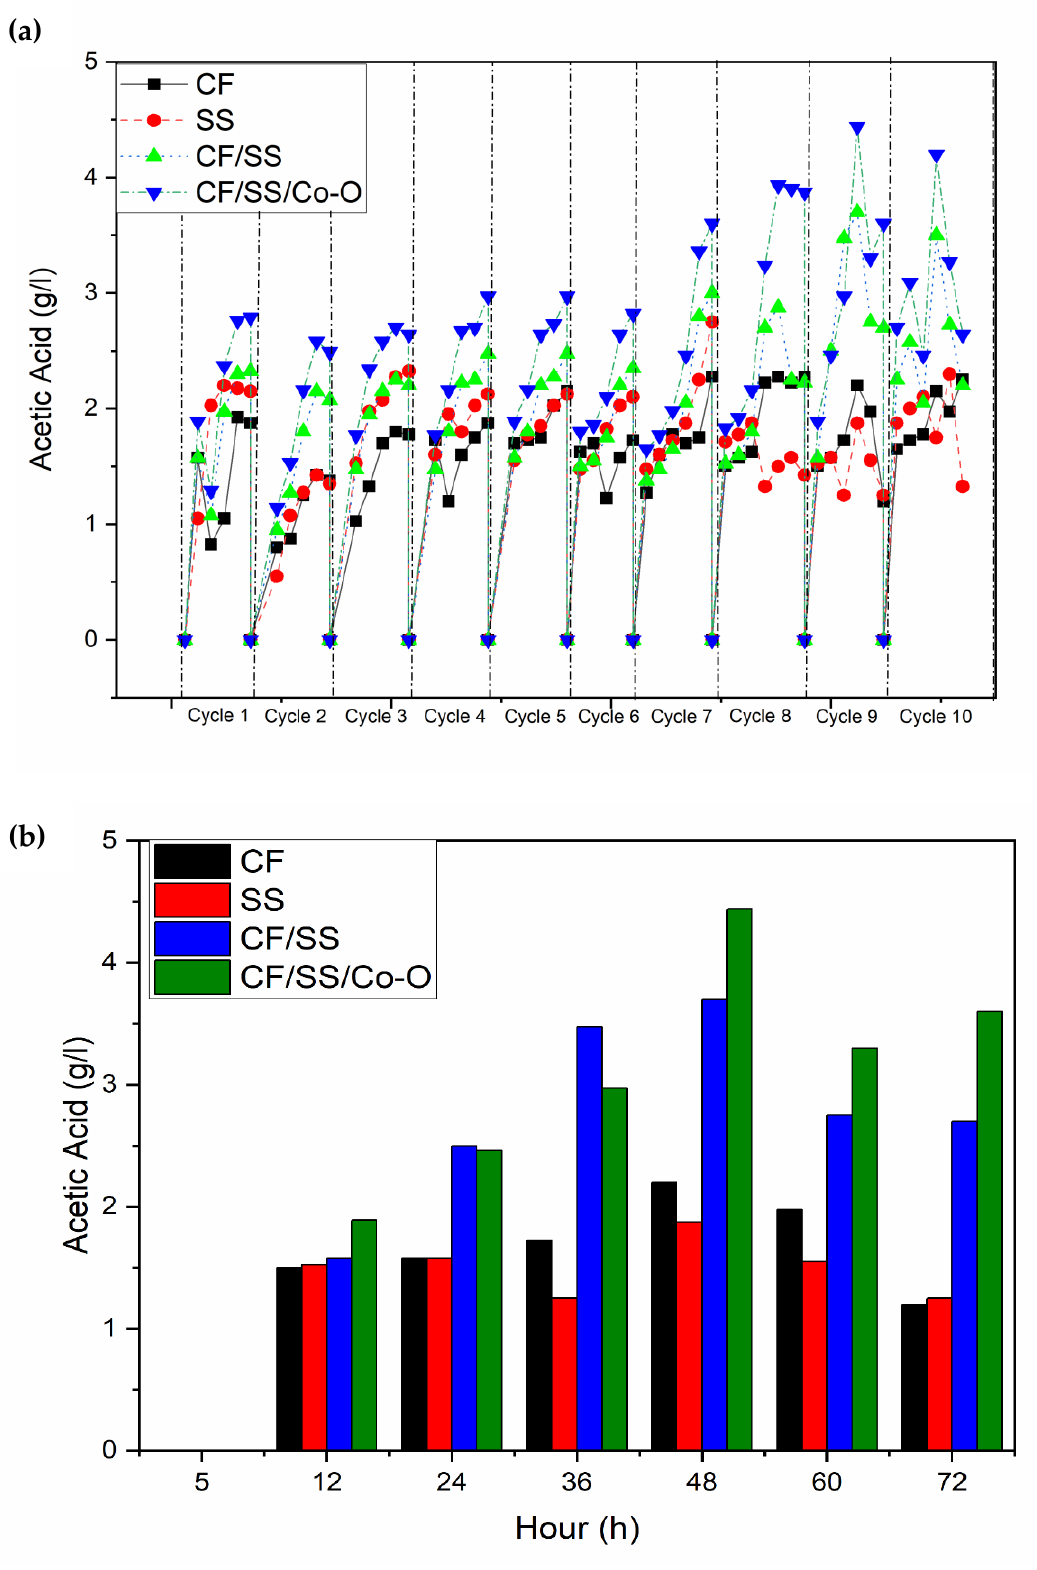
Figure 3. Acetic acid profile. ( a ) MES operated with different biocathodes for ten consecutive cycles. ( b ) A batch cycle with an HRT of 72 h.